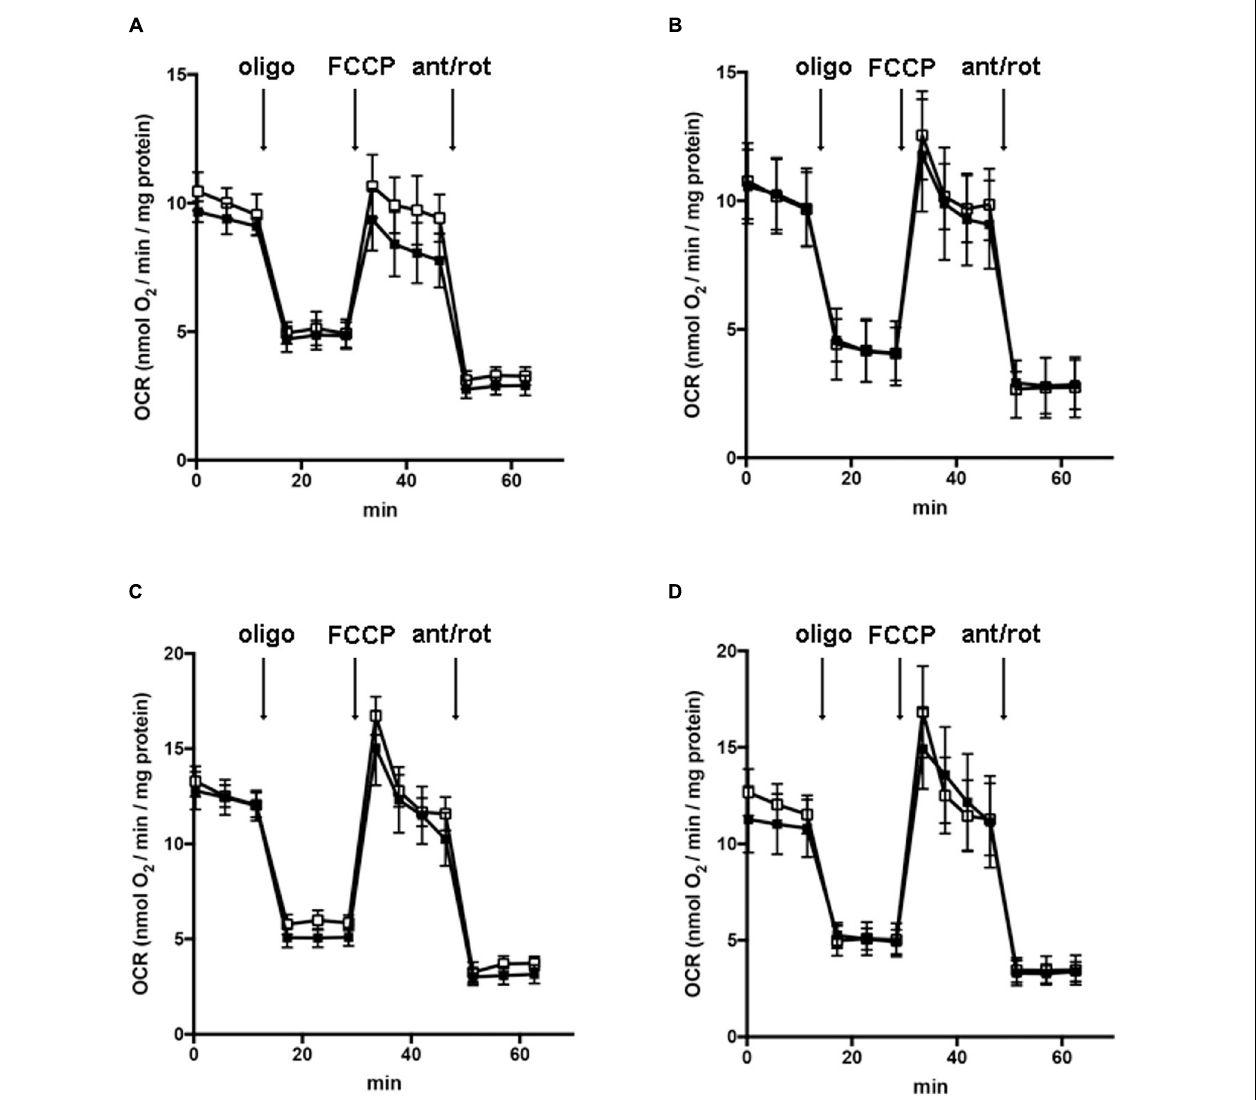
FIGURE 1 | Downregulation of AGC1 does not inhibit mitochondrial respiration in Oli-Neu cells. Oxygen consumption rates (OCRs) were measured with XF 96 extracellular flux analyzer (SeaHorse; Agilent Technologies, MA, United States) in control ( (cid:3) ) and siAGC1 Oli-Neu ( (cid:4) ) cells incubated for 1 h in XF base medium supplemented with 1 g/l glucose (A) , 1 g/l glucose with 1 mM pyruvate (B) , 1 g/l glucose with 2 mM glutamine (C) , or 1 g/l glucose with 1 mM pyruvate with 2 mM glutamine (D) . Oli-Neu cells were exposed to sequential additions of 2 µ M oligomycin, 0.5 µ M FCCP, and 1 µ M antimycin A with 1 µ M rotenone. OCR data were normalized to cell protein content. Mean values ± SD from three independent experiments each including 5–6 replicates per cell type are shown.